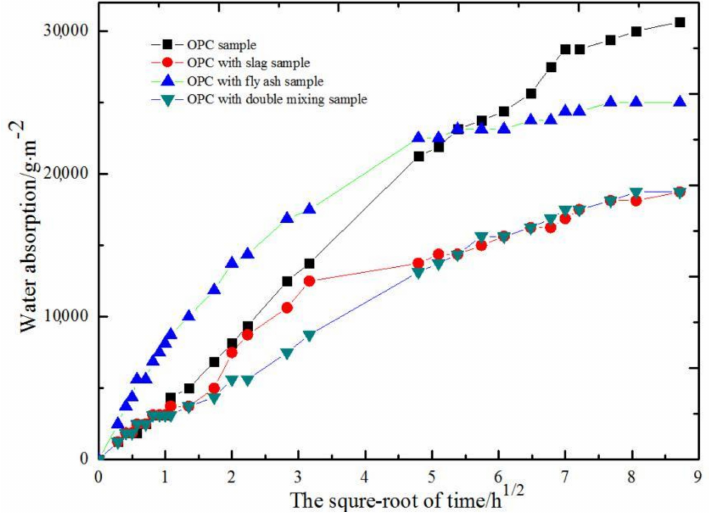
Figure 2. Relationship between water absorption and square root of time (7 days cured concrete).